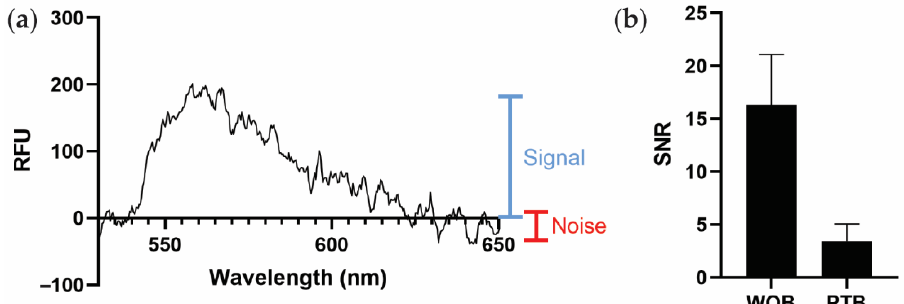
Figure 3. Comparison of biosensor performance. ( a ) Graphical representation of signal (blue) and noise (red) on a spectrum of PTB recorded with 1 nM SA-AF532, as used to estimate the signal-to-noise ratio (SNR) in this work. RFU: relative fluorescence units. ( b ) Comparison of average SNRs of WOB and PTB. Error bars are ± one standard deviation ( n = 4).